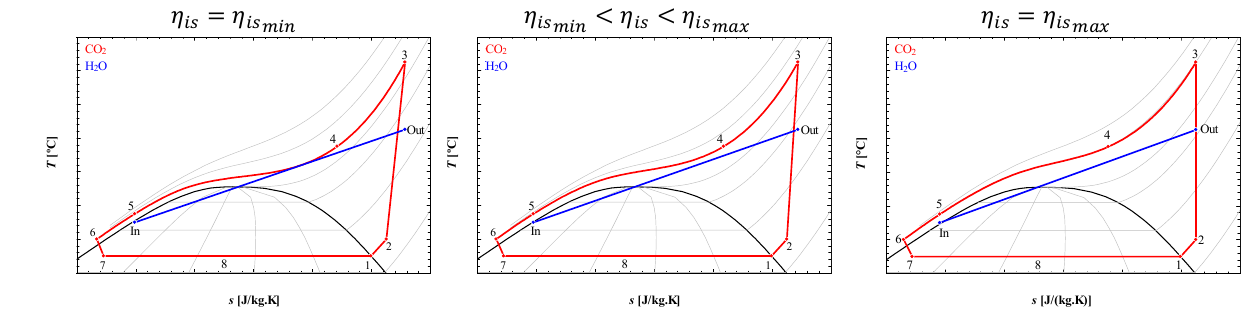
Figure 3. Definition of the search range for η is .